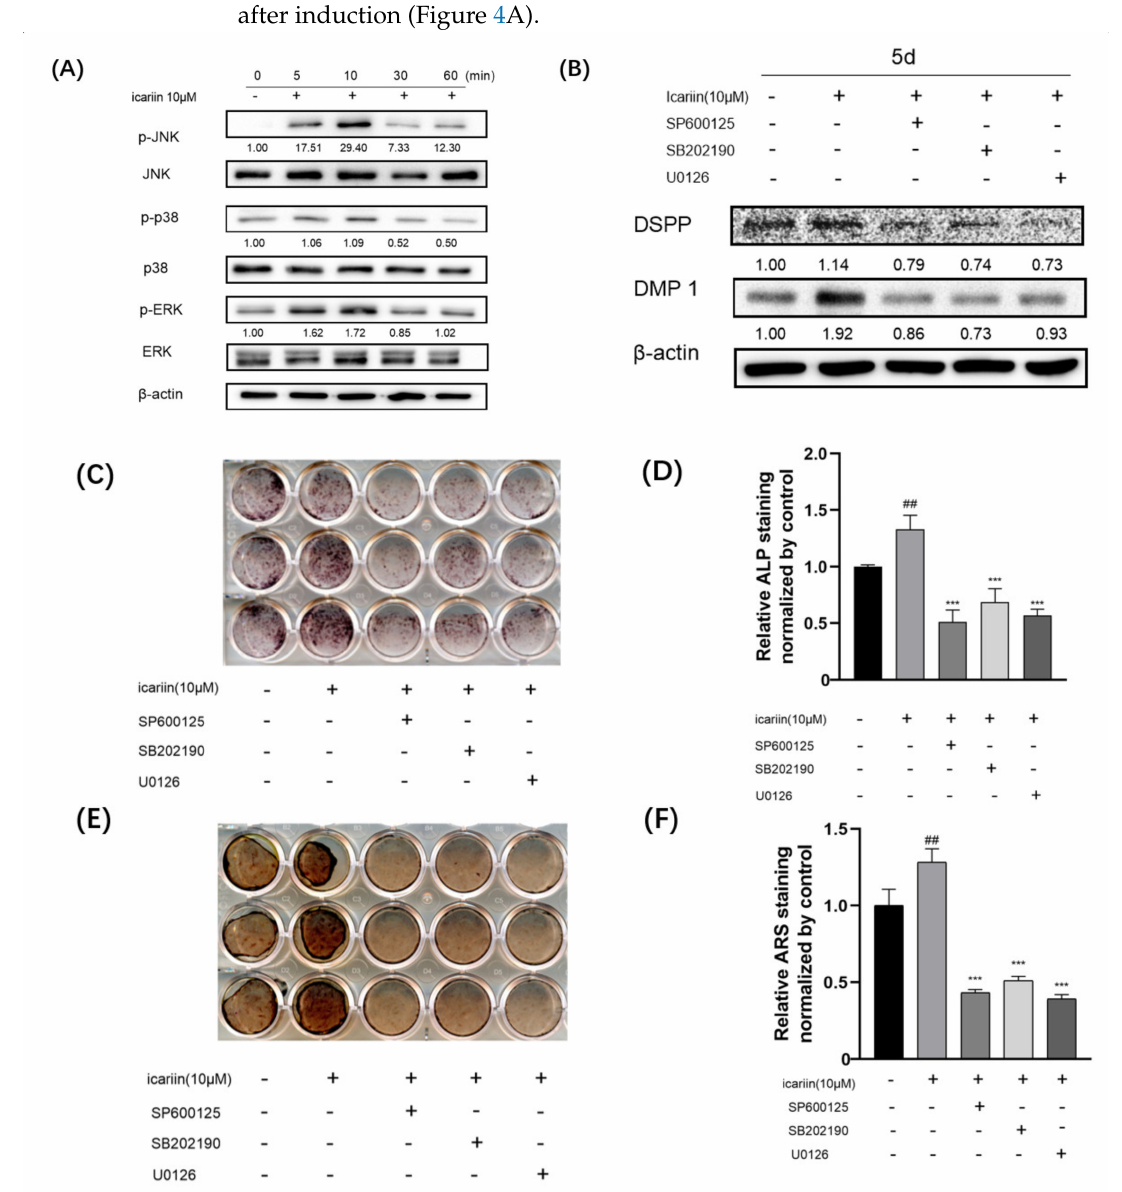
Figure 4. MAPK signaling pathway involved in icariin-mediated odontogenic differentiation of HDPCs. ( A ) Icariin activated MAPK pathways in HDPCs, JNK, p38, and ERK total proteins and phosphorylated proteins were assayed by western blot for the indicated time points (0, 5, 10, 30, and 60 min). ( B ) MAPK inhibitors (SP600125, SB202190, and U0126) suppressed expression levels of DSPP and DMP 1 proteins. ( C , D ) Icariin induced ALP activities were significantly blocked by the presence of MAPK inhibitors. ( E , F ) Icariin enhanced calcium deposition of HDPCs by mainly restraining MAPK inhibitors. Results were normalized to OM. Bars show means ± standard deviation (## p < 0.01 compared to OM; *** p < 0.001 compared to OM with icariin treatment). (MAPK: Mitogen-activated Protein Kinase, SP600125: JNK inhibitor, SB202190: p38 inhibitor, and U0126: ERK